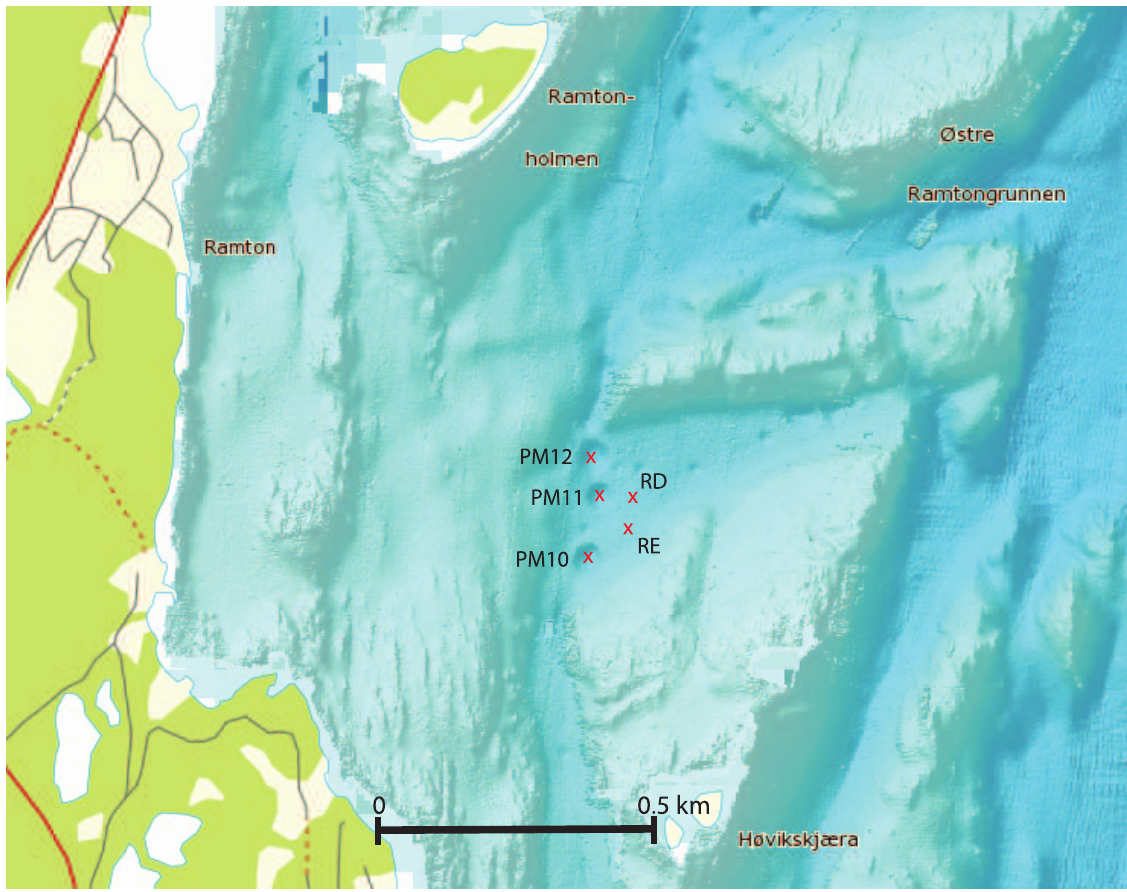
Figure 1. Bathymetric map of the sampling area in the Oslofjord. The red crosses indicate the sampling sites and the sampling site designation is given. The map was generated with the www.mareano.no website.